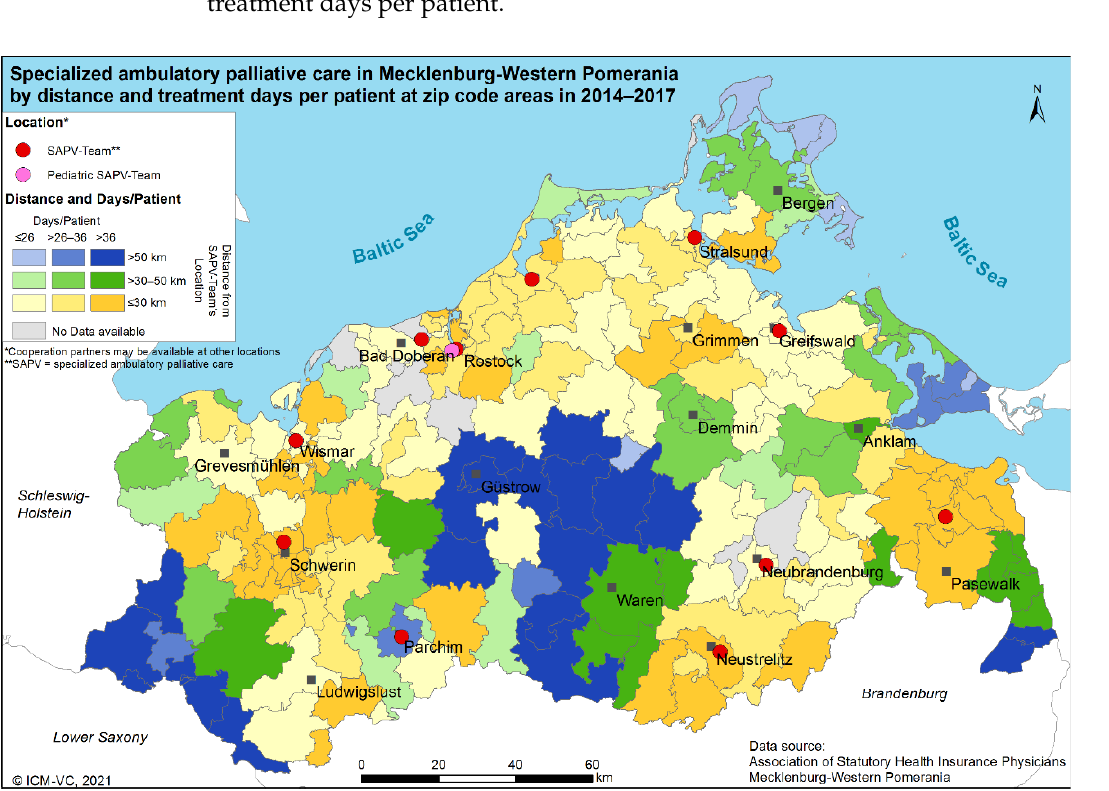
Figure 1. SAPV in Mecklenburg-Western Pomerania by distance and treatment days per patient at the level of zip code areas in 2014 – 2017. * Cooperation partners may be available at other